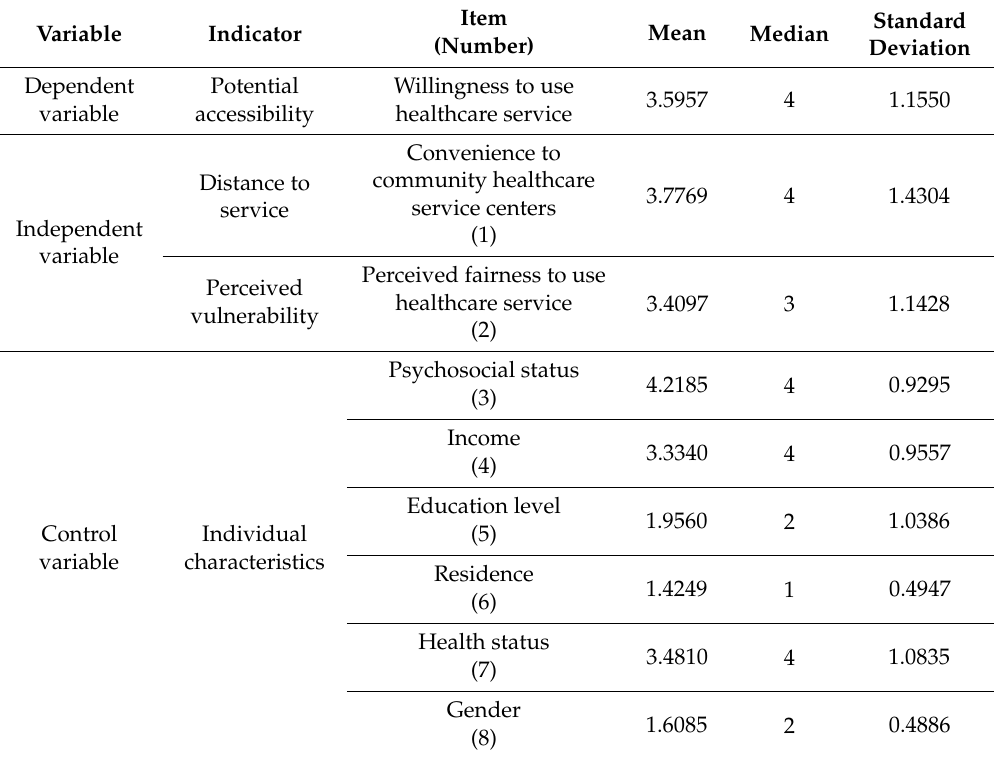
Table 1. Descriptive statistics of the study